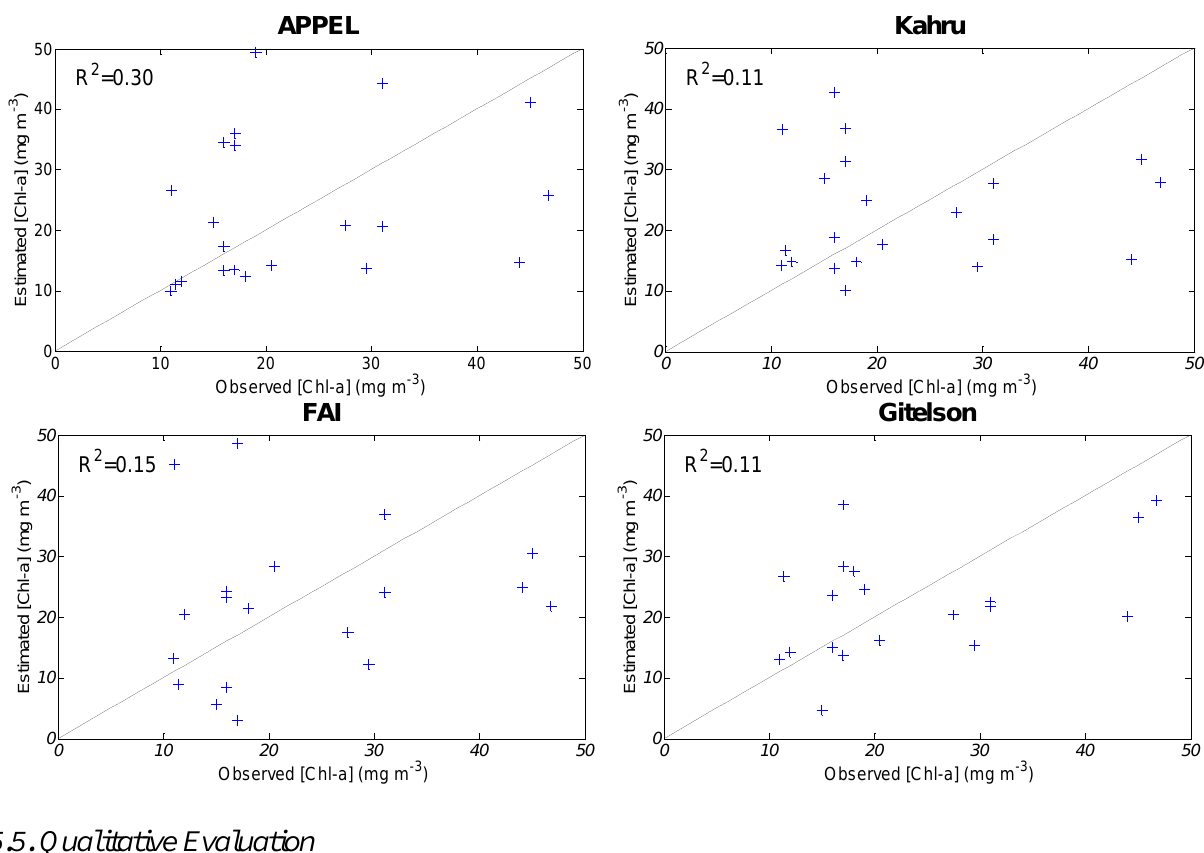
Figure 10. Chlorophyll-a concentration estimated from the four models compared to in situ measurements under moderate concentrations (between 10 and 50 mg∙m –3